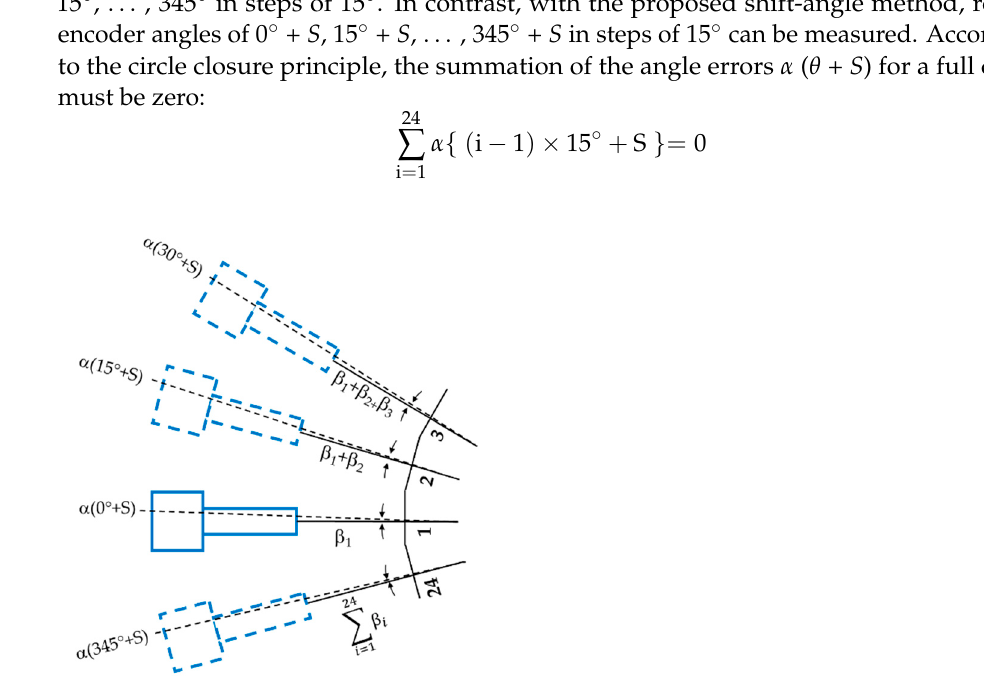
Figure 2. Schematic of the calibration value determination.